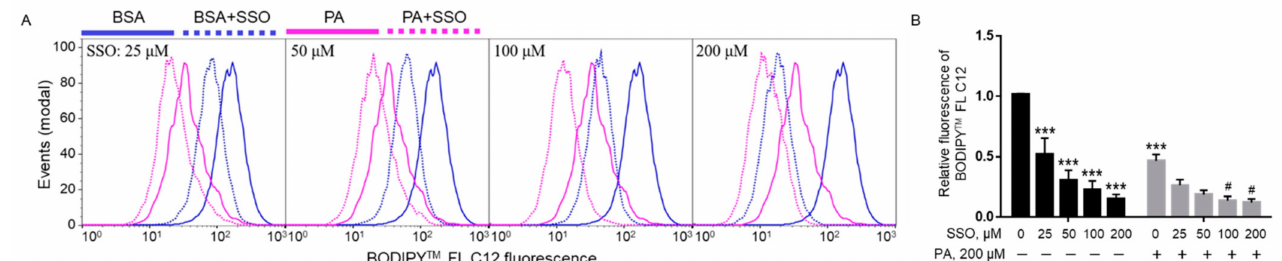
Figure 5. Uptake of BODIPY TM FL C12 in BV2 cells pre-treated with SSO for 1 h followed by treatment with PA or BSA for 6 h. Cells were pre-treated with different concentrations of SSO for 1 h and then treated with 200 µ M PA or BSA for 6 h. At the end of treatment, cells were incubated with BODIPY TM FL C12 for 30 min, and fatty acid uptake was measured by flow cytometry with representative histograms shown in ( A ) and quantitated data shown in ( B ). Data presented (mean ± SEM) were representative of three independent experiments. Statistical analysis was performed using two-way ANOVA followed by Tukey’s multiple comparison test. *** p < 0.001 vs. BSA control; # p < 0.05 vs. 200 µ M